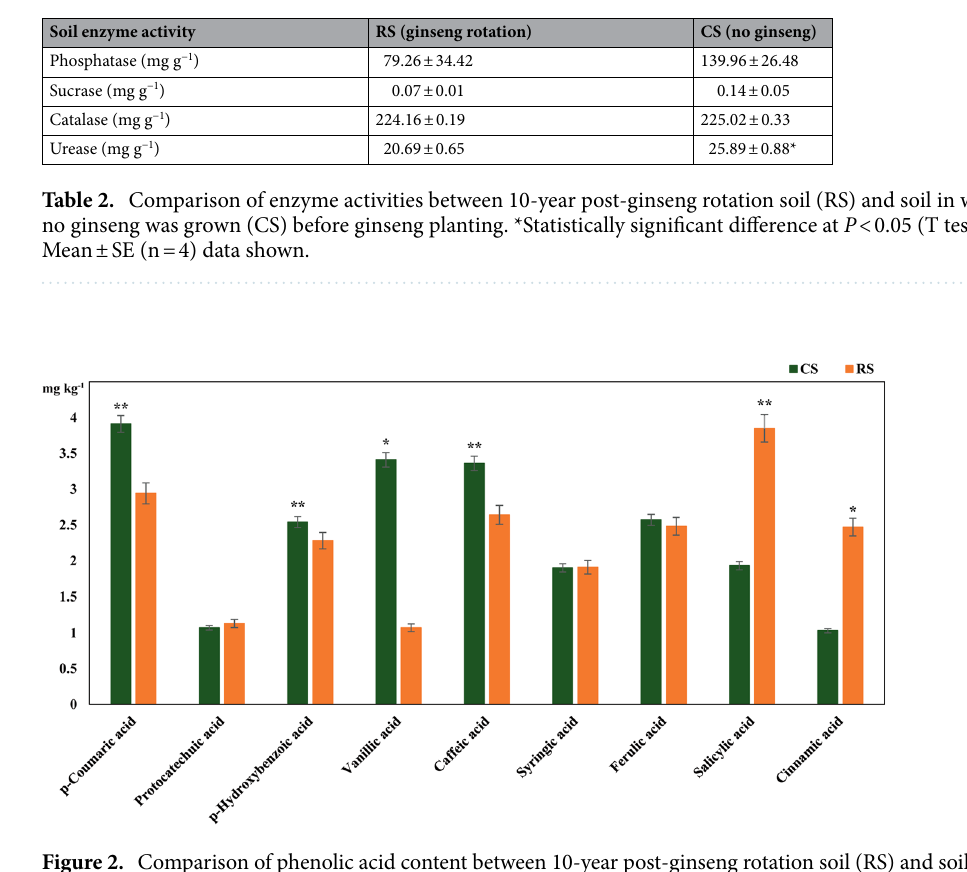
Figure 2. Comparison of phenolic acid content between 10-year post-ginseng rotation soil (RS) and soil in which no ginseng was grown (CS) before ginseng planting. *Represent significant differences ( P < 0.05) according to Student’s t-test (n = 4). **Represent significant differences ( P <